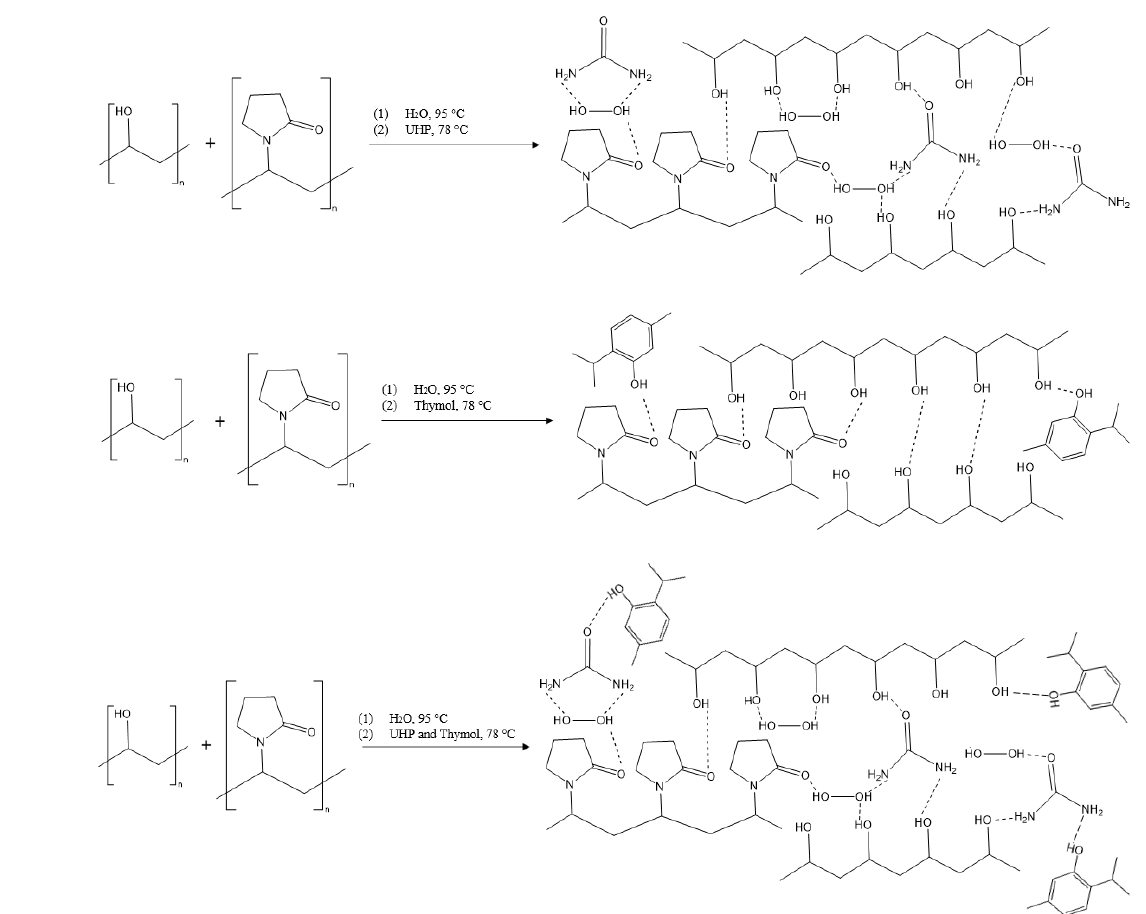
Figure 1. Preparation of PVA/PVP hydrogel with HP ( A ), thymol ( B ) or both ( C ).